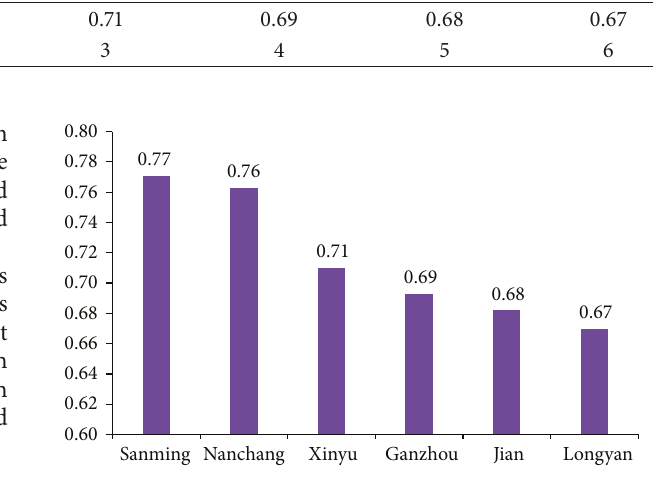
Figure 6: Deng’s correlations between Xiamen Port and its dry